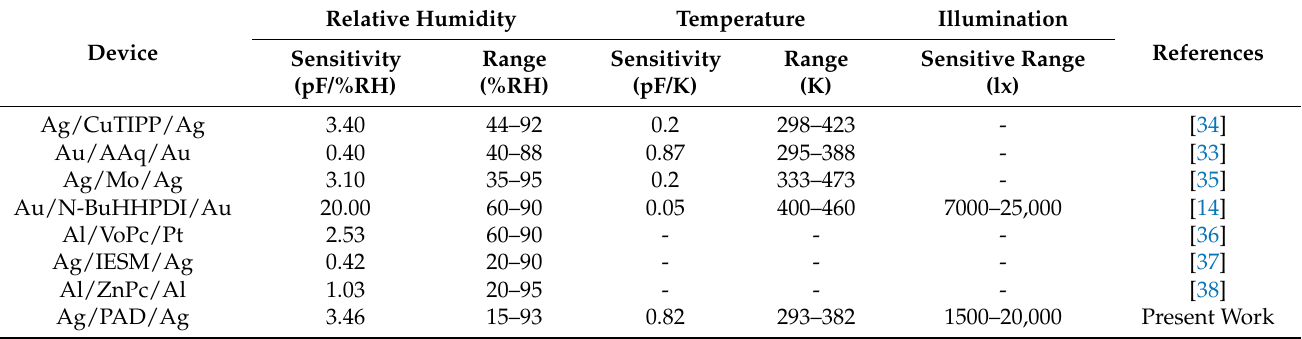
Table 2. Comparison of present work with